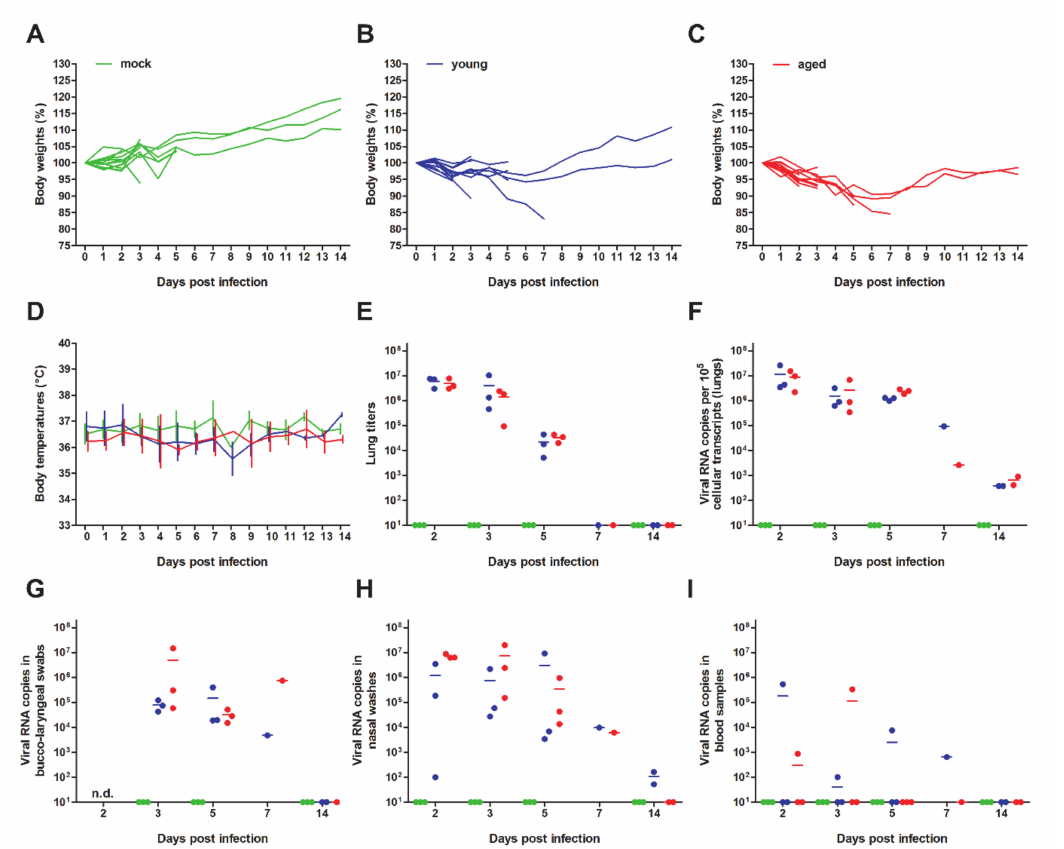
Figure 1. Body weight changes, body temperatures, and viral loads of young versus aged